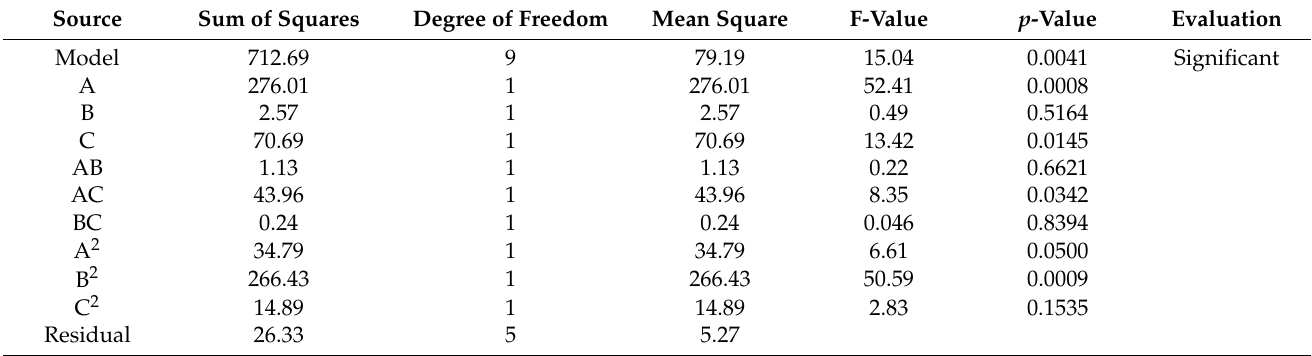
Table 6. Variance analysis of the quadratic polynomial model for release 1 .